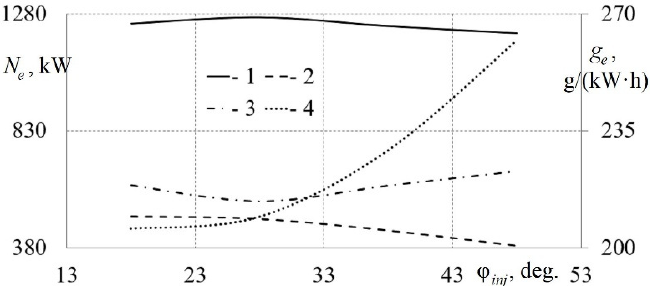
Figure 7. Dependences of power N e and specific fuel consumption g e on the fuel injection advance angle φ inj at different modes: 1— N e = f ( φ inj ) at the nominal engine mode; 2— N e = f ( φ inj ) at idle; 3— g e = f ( φ inj ) at nominal mode; 4— g e = f ( φ inj ) at idle.